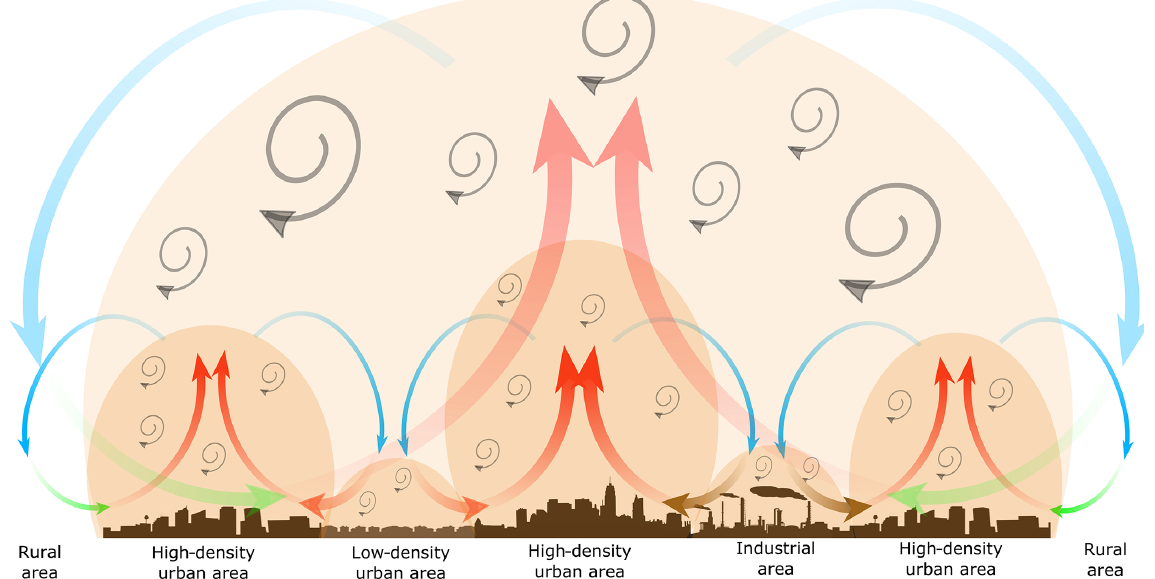
Figure 4. A schematic figure showing a complex structure of an urban heat island (UHI) in the gigacity, where, within one large UHI, multiple individual UHI circulation patterns are formed between the lower- and higher-density urban areas with a lack of rural areas. Within the gigacity, the UHI circulation is not bringing cooler and cleaner air from rural areas but draws in already warm air from the lower-density urban areas and even highly polluted air from the industrial areas. Only at the sides of the gigacity is cooler and cleaner air drawn into the city, and it will not penetrate into the middle parts of the gigacity. If the temperature difference between the high-density urban areas in the middle and the lower-density urban areas is not sufficient, the UHI circulation might also be totally suppressed in the middle parts of the gigacity. The complex internal circulation can lead to high ambient temperatures and a high concentration of atmospheric pollutant levels inside the